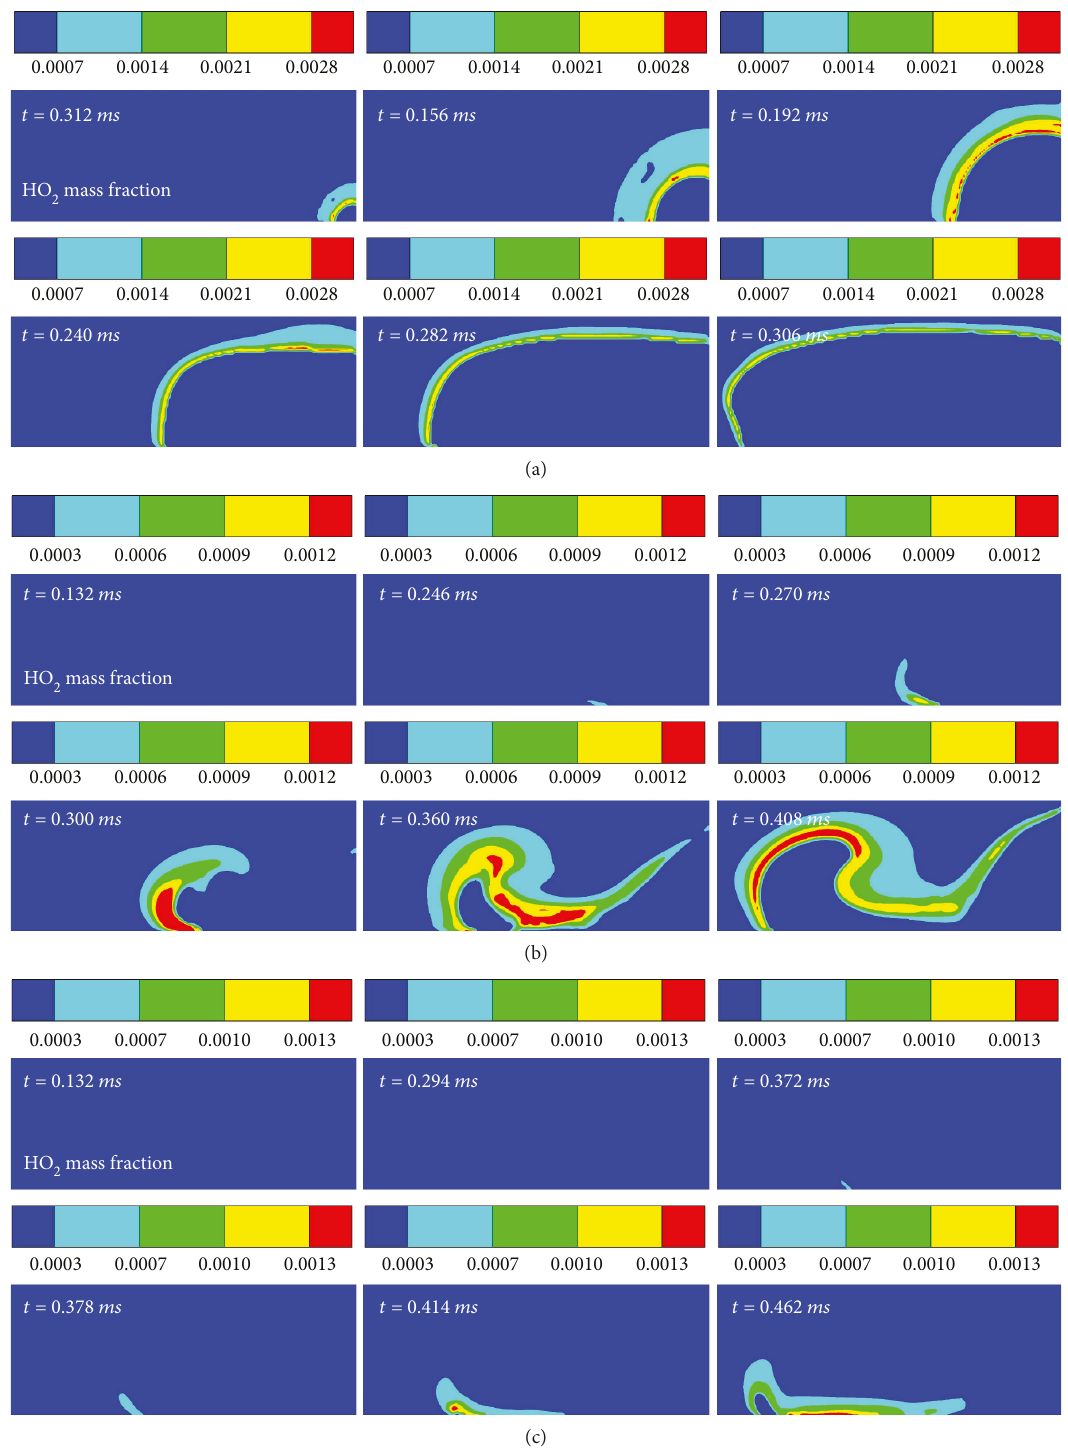
Figure 16: Cloud charts of HO